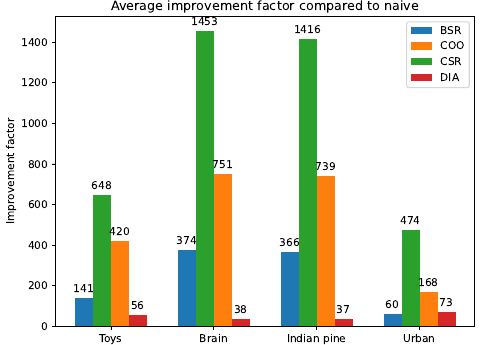
Figure 9. Processing time for CGNE reconstructions in the one-row